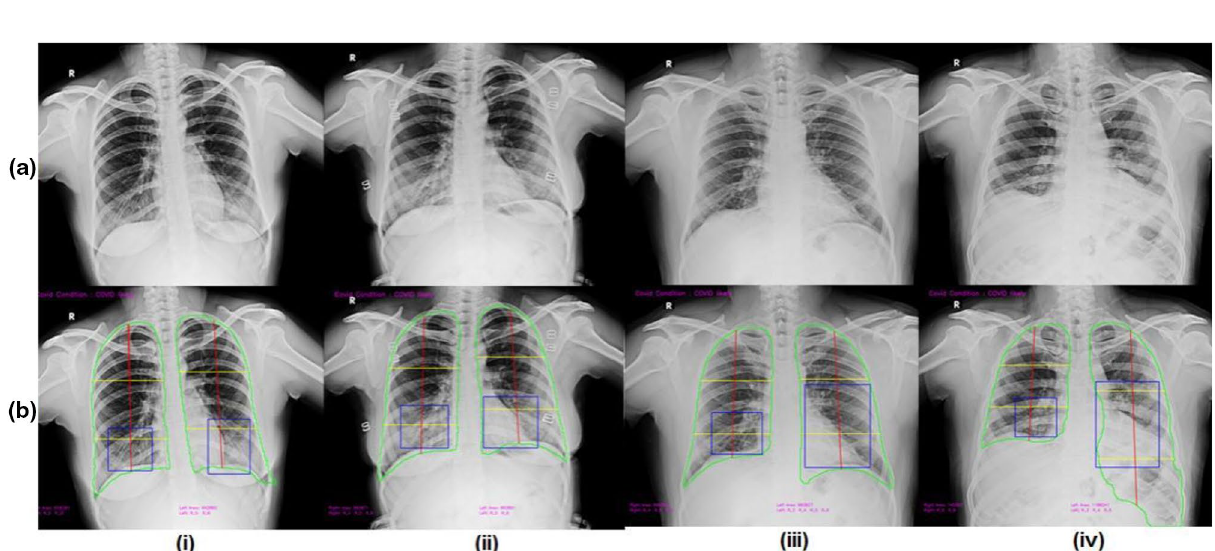
Figure 6. Samples of false-positive from IITAC1.4K dataset ( a ) Ground truth CxR ( b ) CovBaseAI inferencing